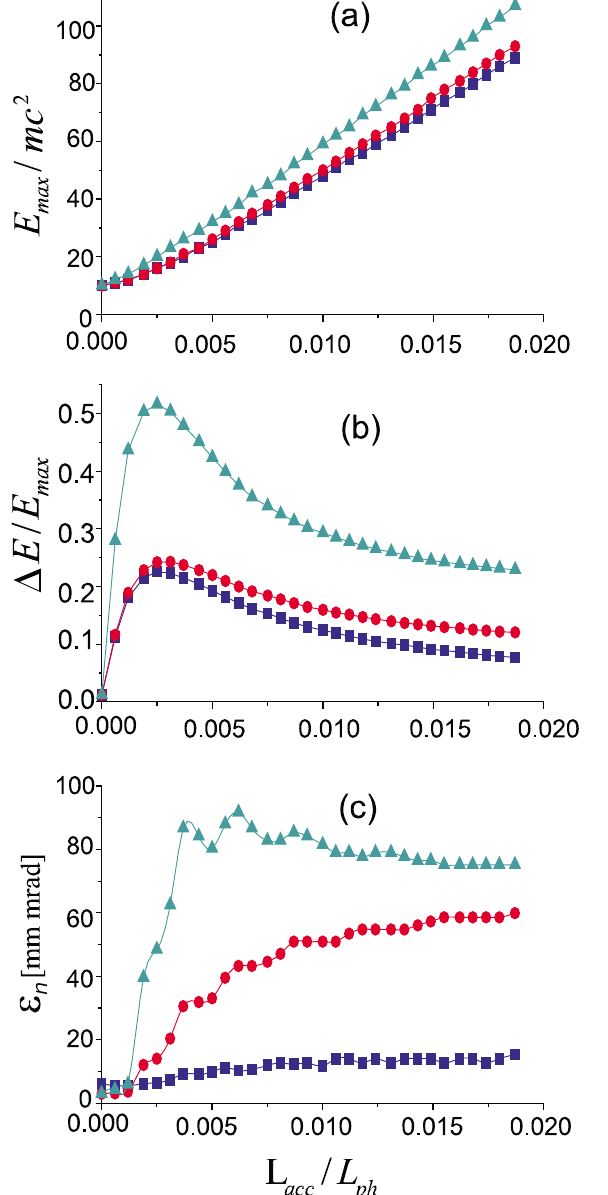
FIG. 5. (Color) The effect of the initial bunch size on the beam quality in the bunching stage; f max (cid:1) 0.19 , other laser and plasma channel parameters are similar to (cid:1) 100 m m, Fig. 4. Triangles: L b 0 (cid:1) 90 m m (300 fs), R 0 a n ´ 0 (cid:1) 0.3 mm mrad; circles: L b 0 (cid:1) 30 m m (100 fs), FIG. 6. (Color) Acceleration of electron bunches extracted from (cid:1) 100 m m, ´ (cid:1) 0.3 mm mrad; squares: L (cid:1) 30 m m R 0 the bunching stage. All the parameters are similar to those b 0 0 a n (cid:1) 50 m m, ´ (cid:1) 0.6 mm mrad. (100 fs), R 0 given in the caption of Fig. 0 a n